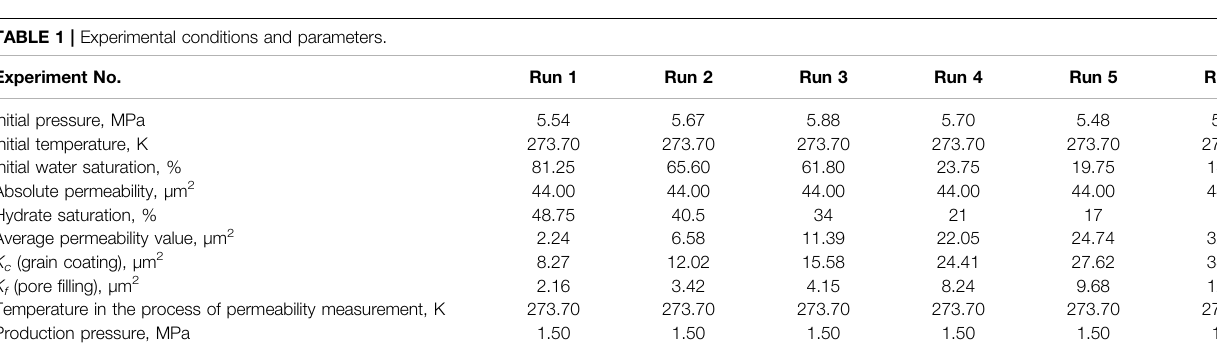
TABLE 1 | Experimental conditions and parameters. Experiment